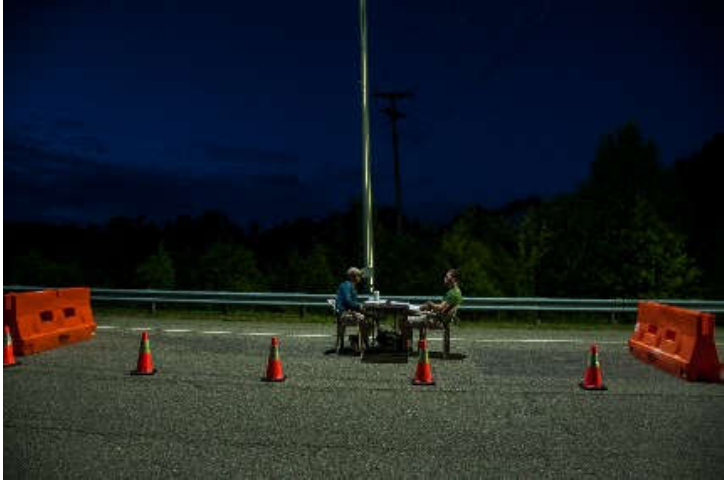
Figure 14. Pedestrian Test Location.